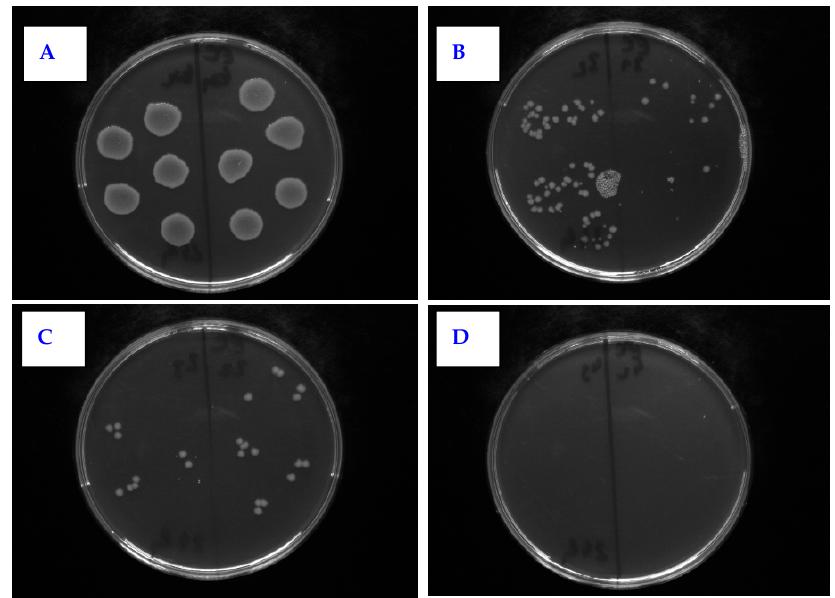
Figure 12. Selected photos of agar plates from antimicrobial tests for PTFE + PLLA against E. coli. The samples were the following: ( A ) control sample; ( B ) plasma 8 W 240 s with 2 g PLLA; ( C ) PLLA 2 g + Ag 50 s 20 mA; ( D ) plasma 8 W 240 s PLLA 2 g + Ag 50